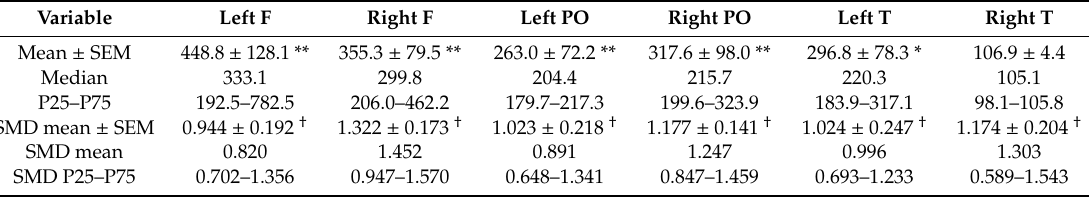
Table A4. Changes in power of beta bands during GS.